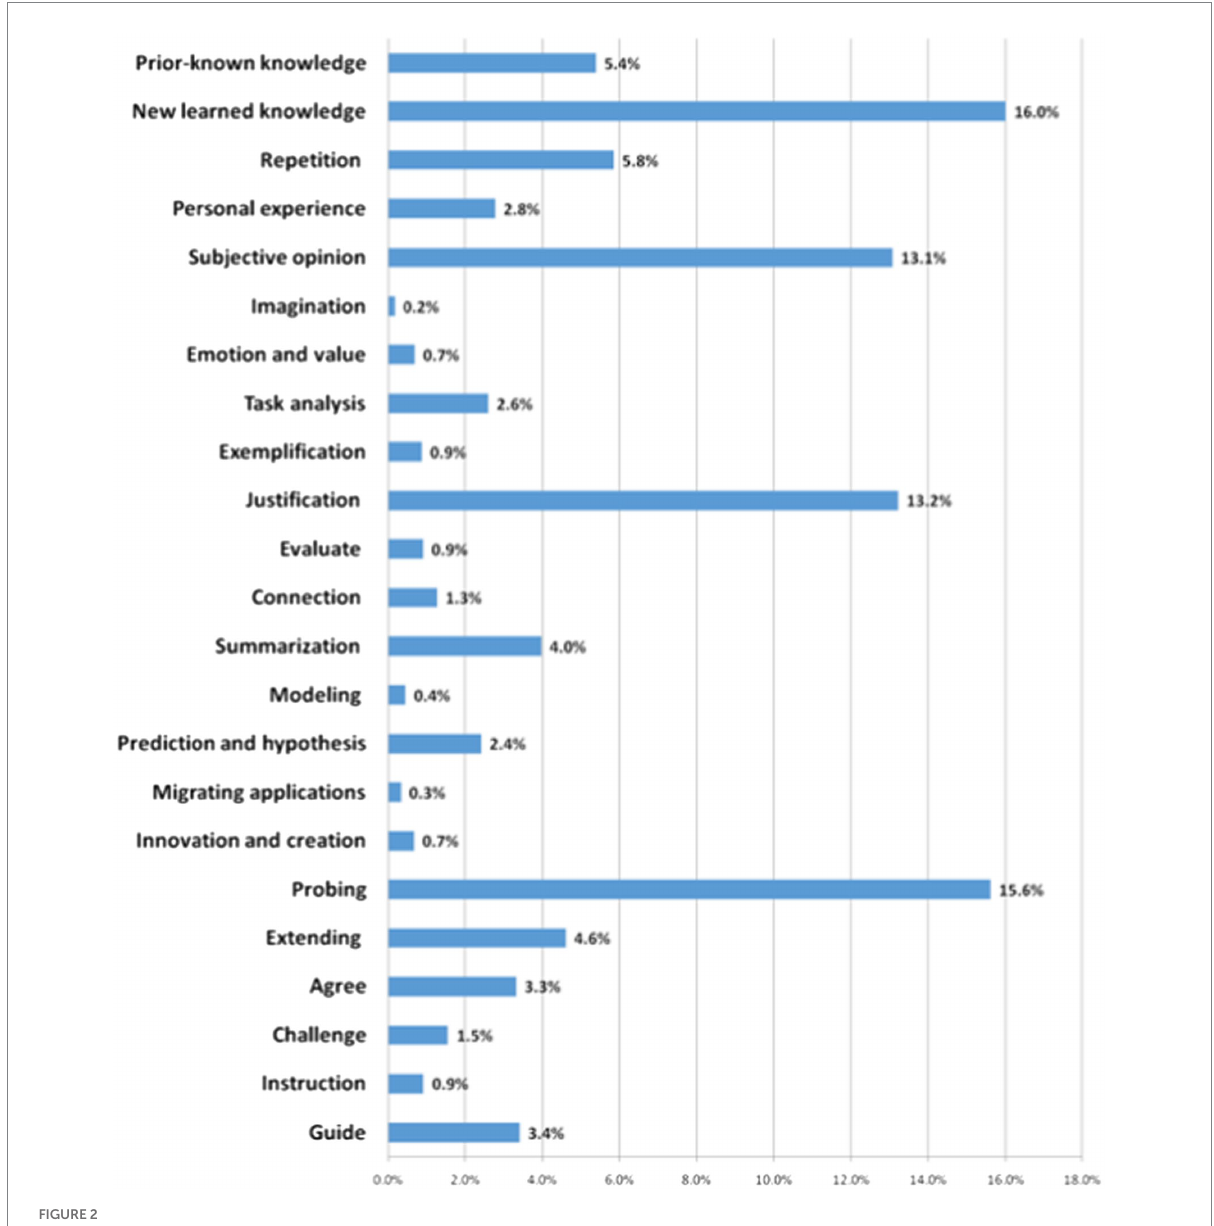
FIGURE 2 Distribution of dialog types in expert teachers’ classrooms (second-level